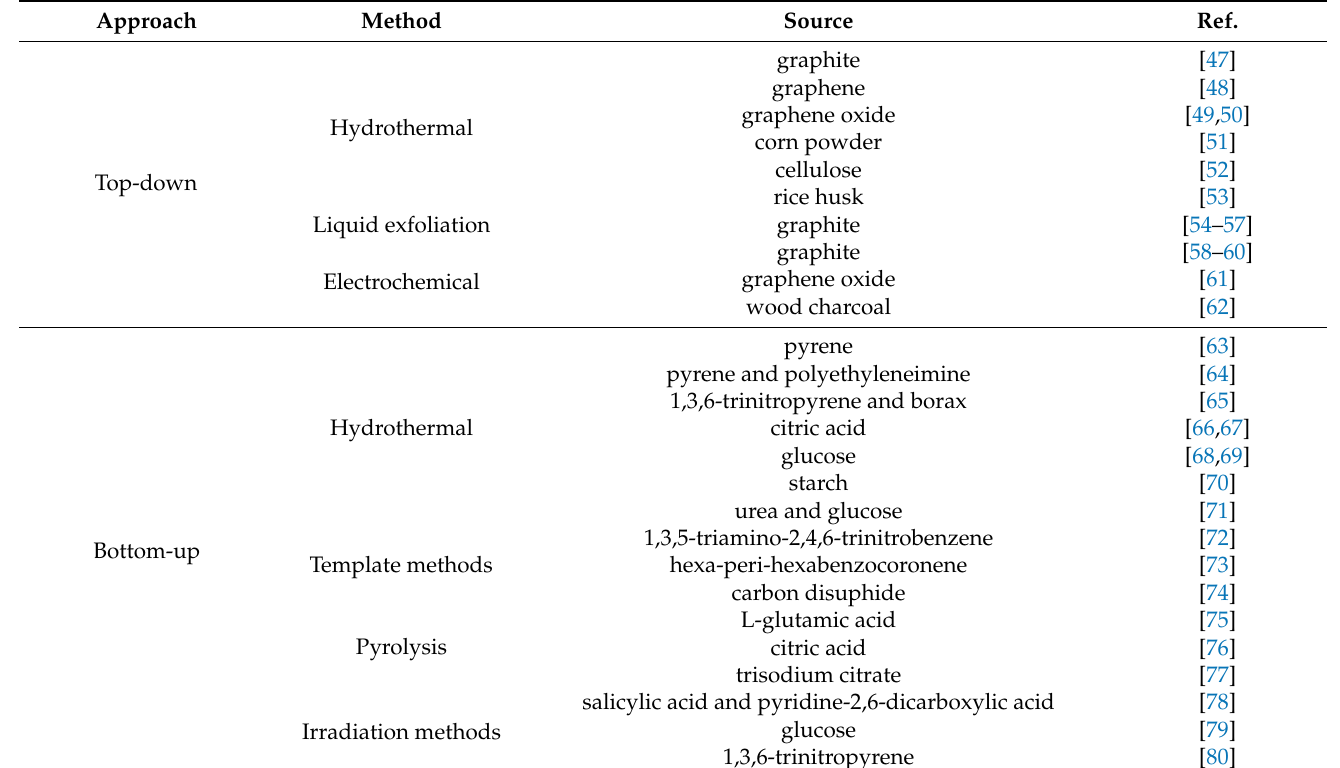
Table 1. Summary of typical approaches for the synthesis of GQDs as biosensing